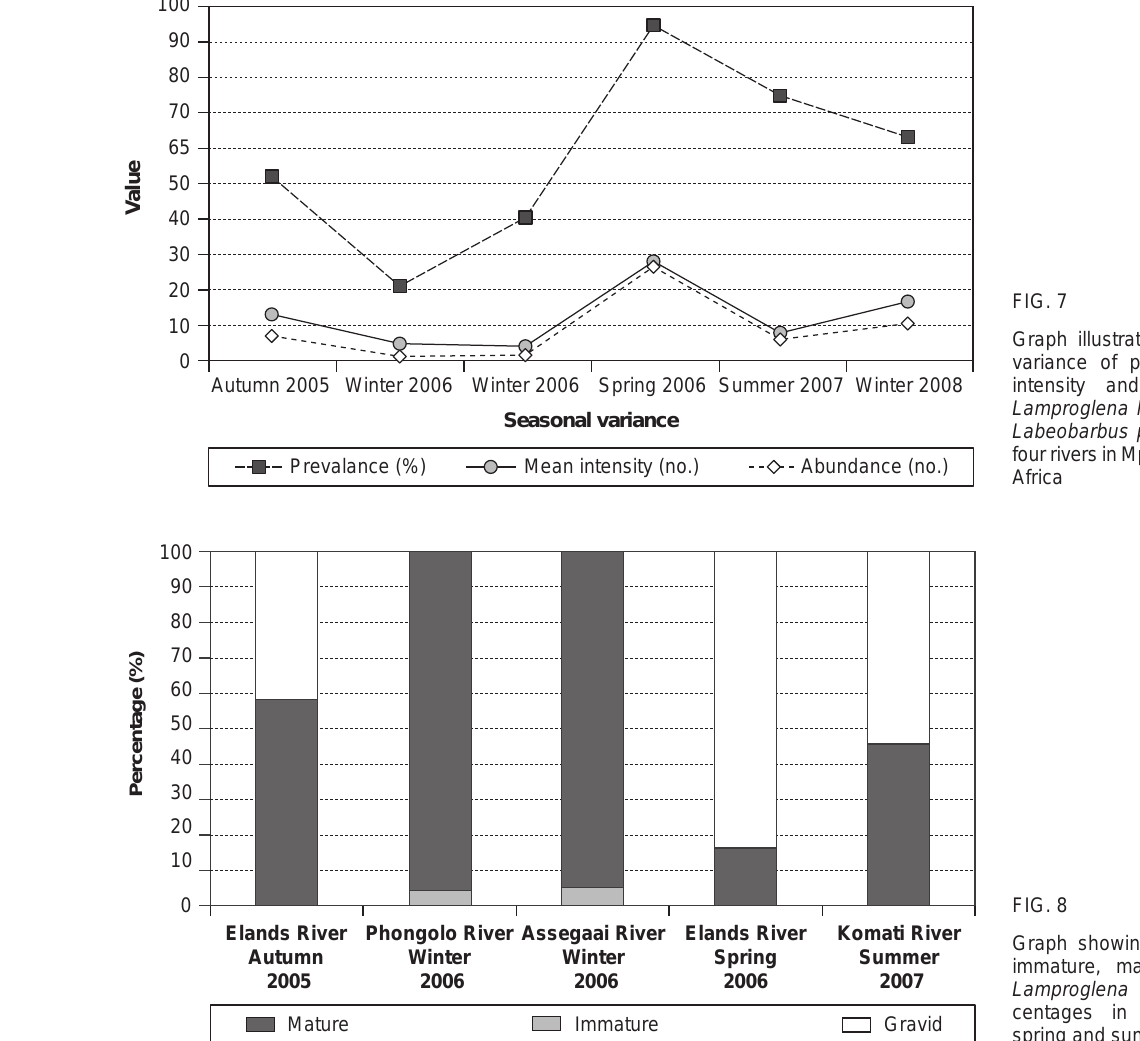
Graph illustrating the seasonal variance of prevalence, mean in tensity and abundance of Lamproglena hoi on the gills of Labeobarbus polylepis found in four rivers in Mpumalanga, South Africa